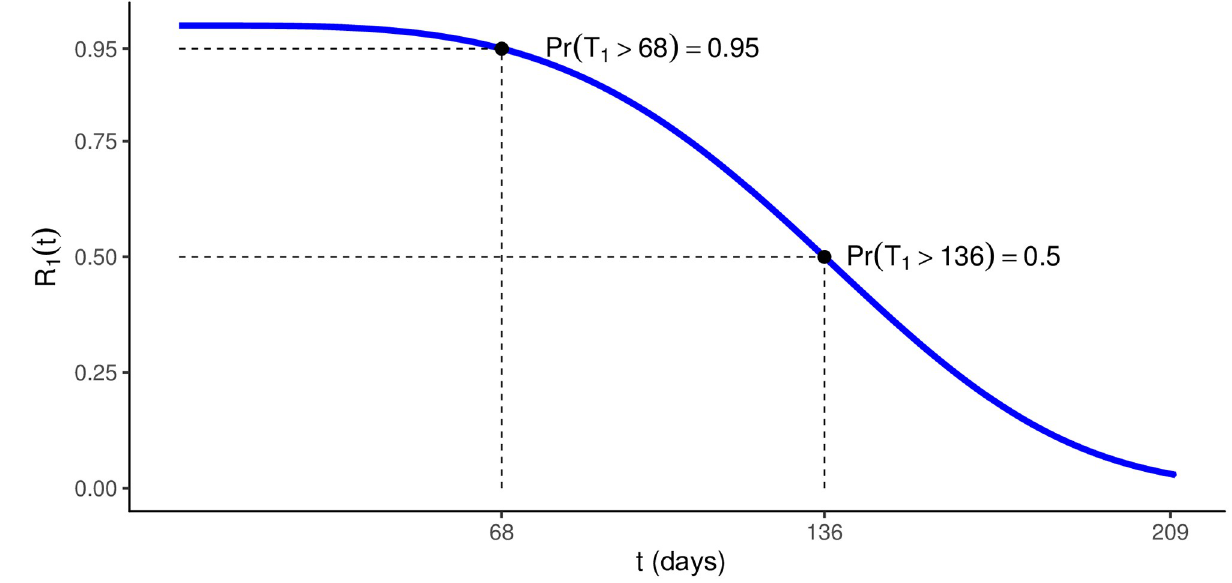
Fig 6. Reliability requirements. Pressure vessel set’s.